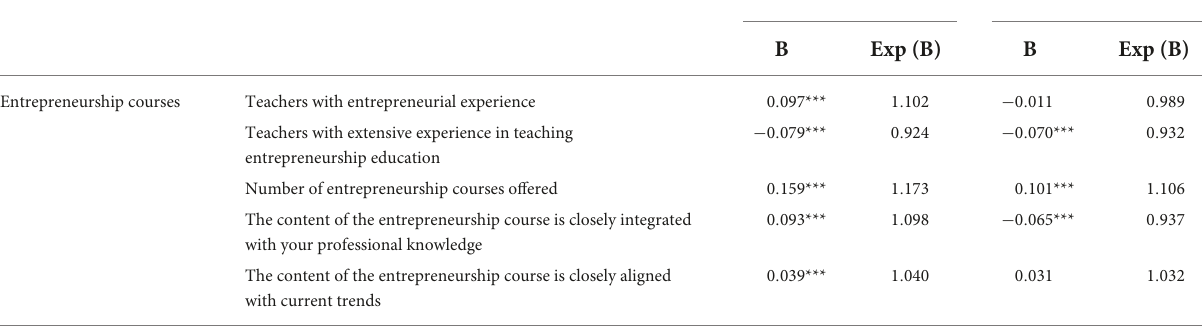
TABLE 5 Results of regression analysis of entrepreneurship curriculum factors on dependent variables.